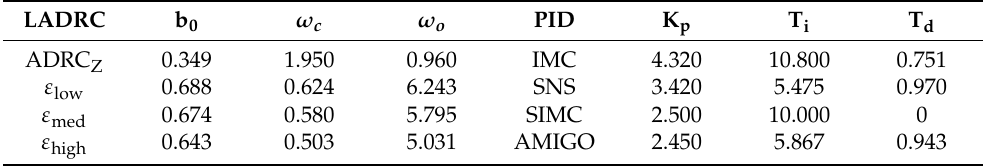
Table 4. Parameters for the control of G 1 ( s )